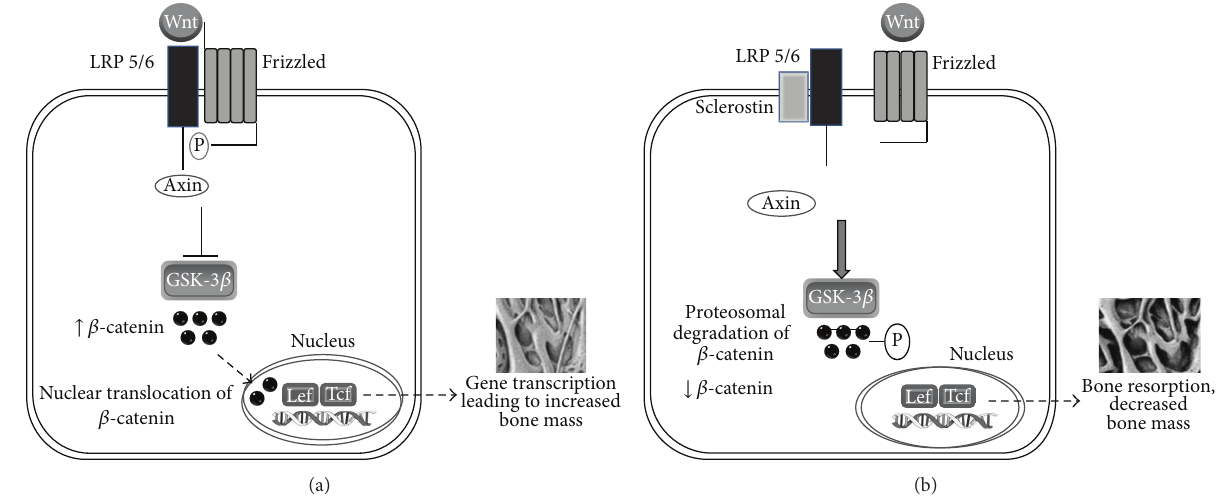
Figure 1: (a) Canonical Wnt signalling involves binding of Wnt to LRP5/6 and its coreceptor Frizzled resulting in the phosphorylation of LRP5/6 thus permitting Axin to bind to the receptor complex. Formation of this complex leads to inhibition of GSK3 𝛽 which prevents degradation of 𝛽 -catenin. Accumulation of cytosolic 𝛽 -catenin leads to nuclear translocation where it activates target gene promoters which result in increased bone mass. (b) Sclerostin inhibition of the Wnt-canonical pathway in osteogenesis. Sclerostin binding to LRP receptor 5/6 prevents Wnt binding and formation of the Frizzled-LRP complex and thus Axin remains unphosphorylated. Downstream effects include activation of GSK3 𝛽 resulting in phosphorylation of cytosolic 𝛽 -catenin, thus targeting it for degradation. In the absence of 𝛽 -catenin accumulation and subsequent nuclear translocation, osteogenesis is